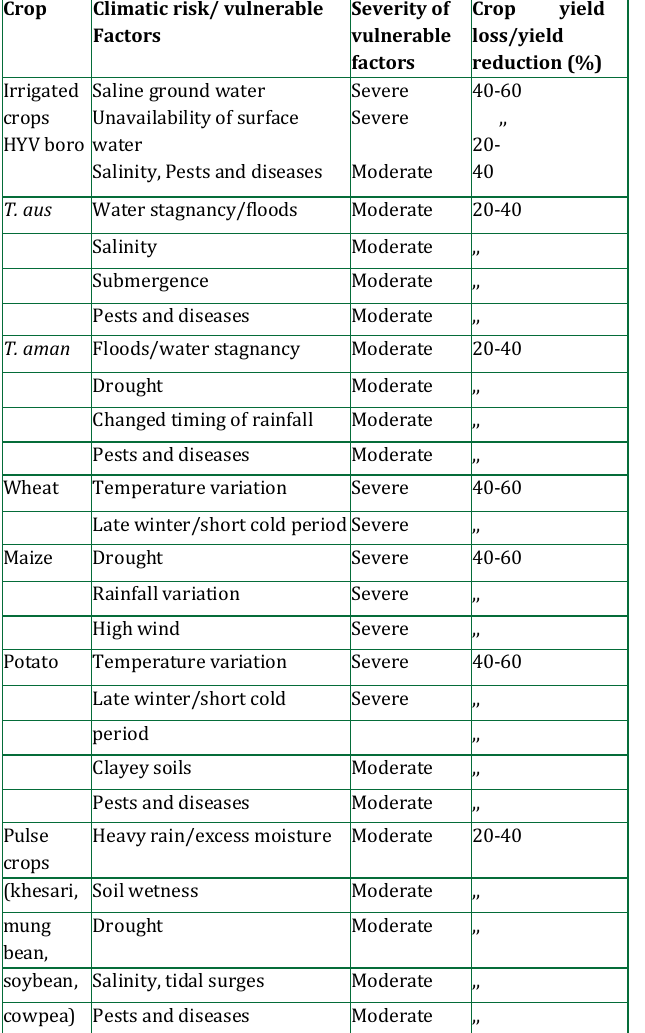
Table 3: Impacts of different climatic risk factors on crop production at Banskhali upazila of Chattogram district